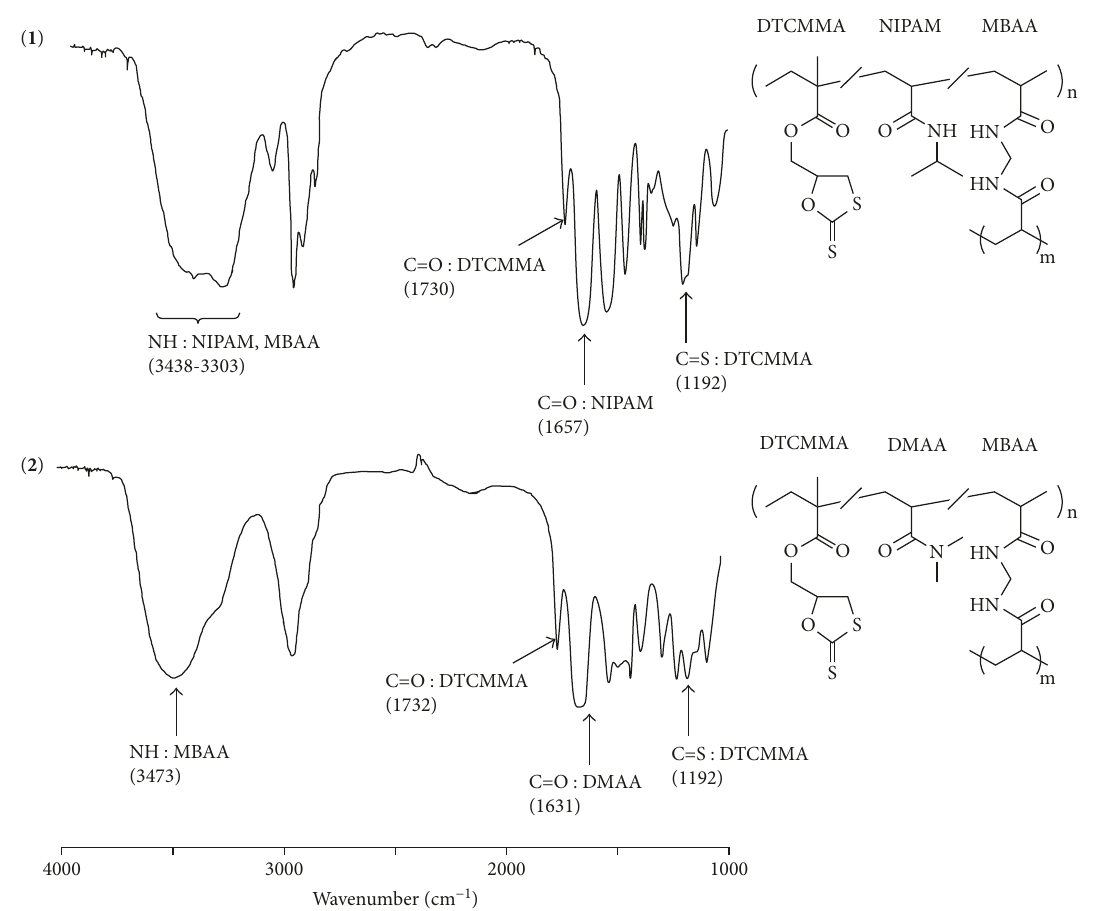
Figure 1: FT-IR spectra of hydrophilic sulfur-containing adsorbents ( 1 ) and ( 2